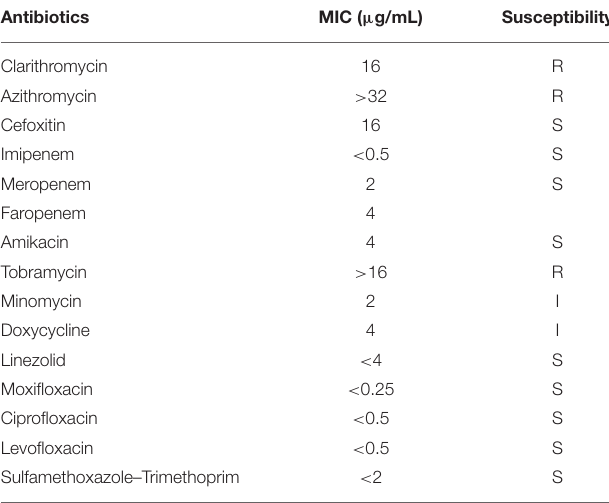
TABLE 1 | Susceptibility of the